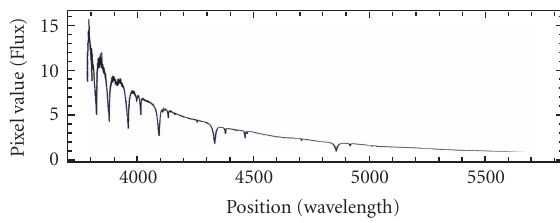
Figure 9: A comparative spectrum: Alcaid spectrum